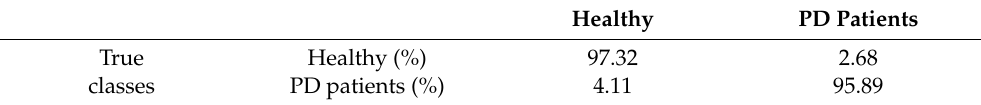
Table 6. Global confusion matrix obtained with Dempster–Sahfer classifier